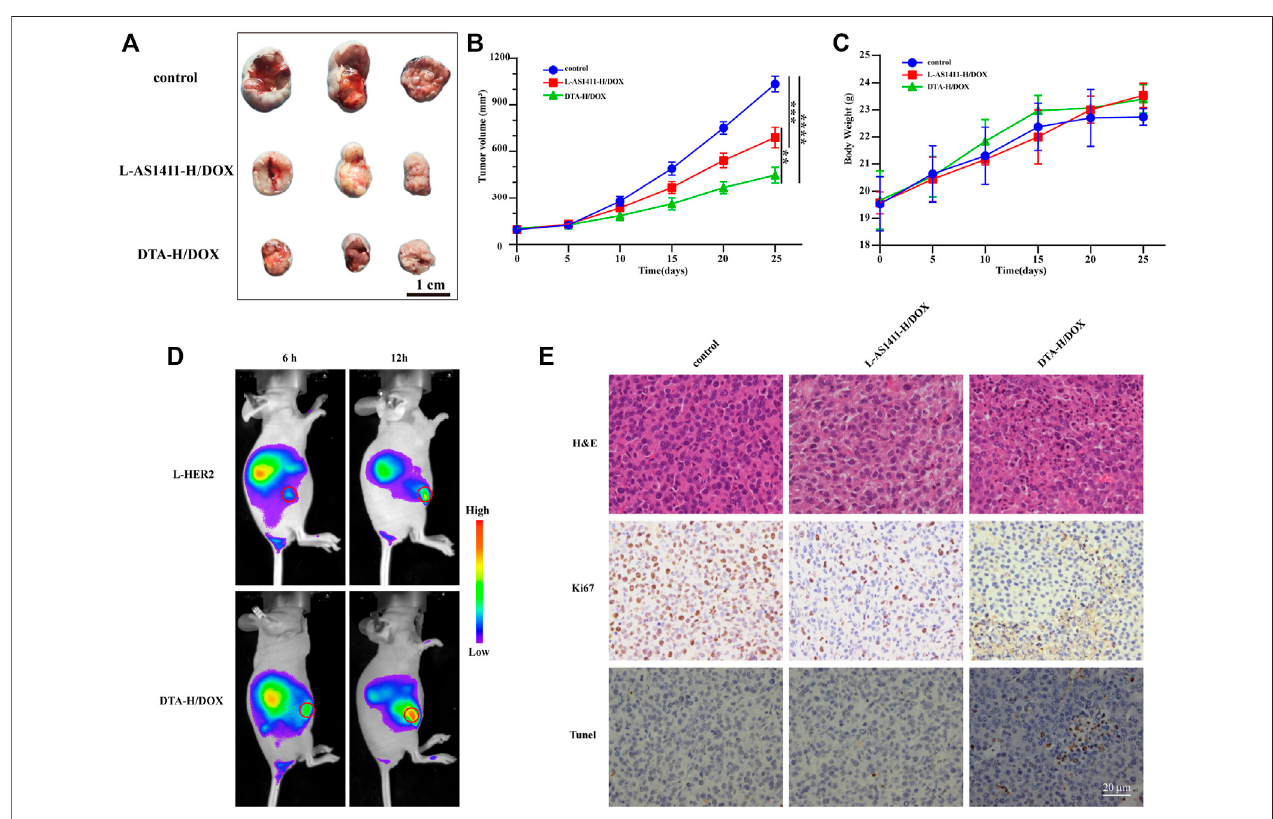
FIGURE 5 | Anticancer ef fi cacy in vivo of DTA-H/DOX. (A) Tumors peeled from the nude mice at the end of the treatment. Scale bar: 1 cm. (B) Tumor growth volumecurveduringtreatment. (C) Changesinbodyweightofmiceduringtreatment. (D) Fluorescenceimaging invivo afterinjectedbytailveinL-HER2-Cy5andDTA-H/ DOX-Cy5 into mice. The tumors are indicated with red circles. (E) H and E, Ki67, and TUNEL staining of the tumor tissues. Scale bar: 20 μ m.